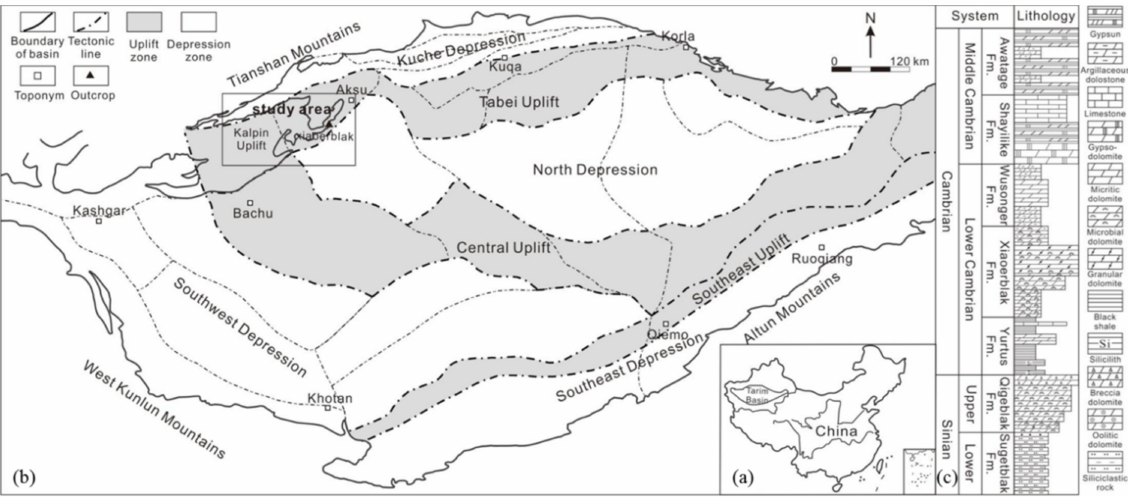
Figure 1. Geological setting map of study area: ( a ) Location of the Tarim Basin in northwestern China; ( b ) Tectonic location of the study area indicated with a grey rectangle; ( c ) Sinian-Lower Cambrian-Middle Cambrian stratigraphic